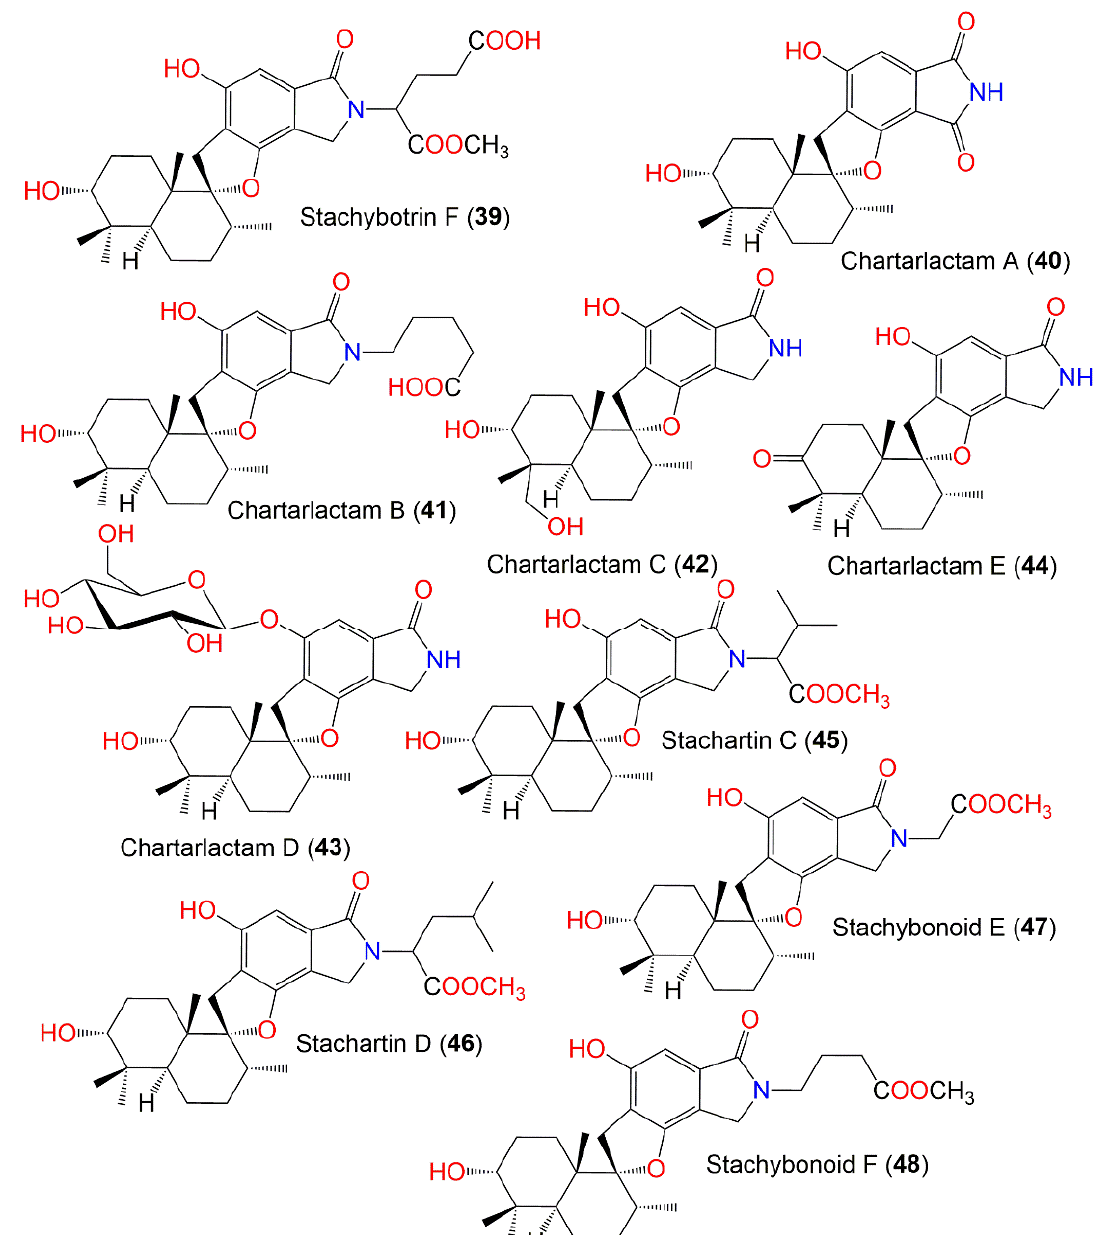
Figure 4. Structures of phenylspirodrimane derivatives ( 39 – 48 ) reported from S . chartarum .